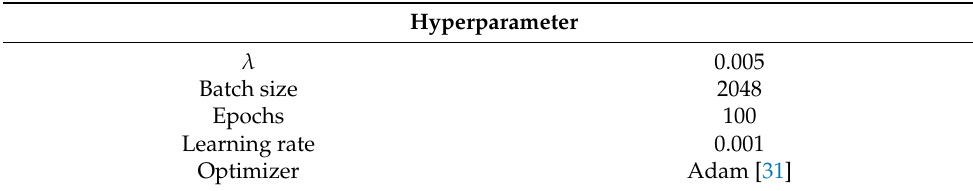
Table 4. Hyperparameter of model.